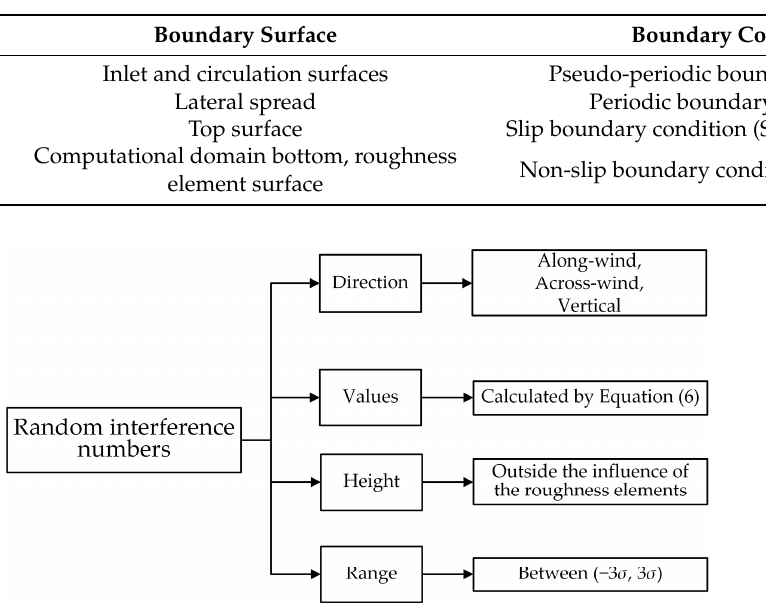
Table 3. Details of the boundary conditions.